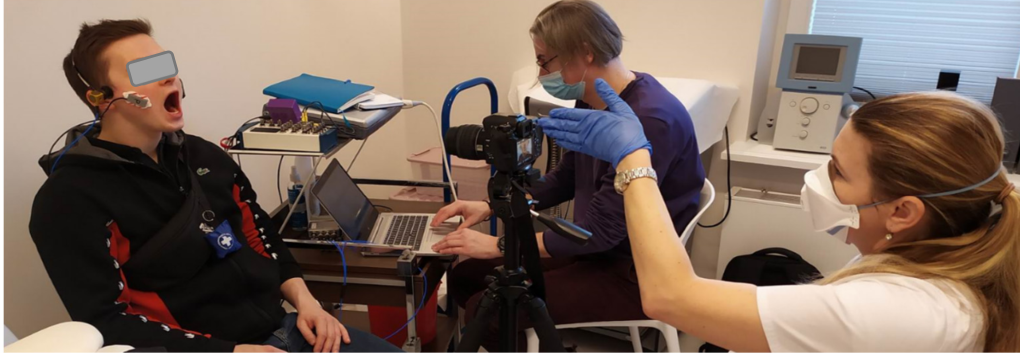
Figure 2. Examination of the patient with TMD—an